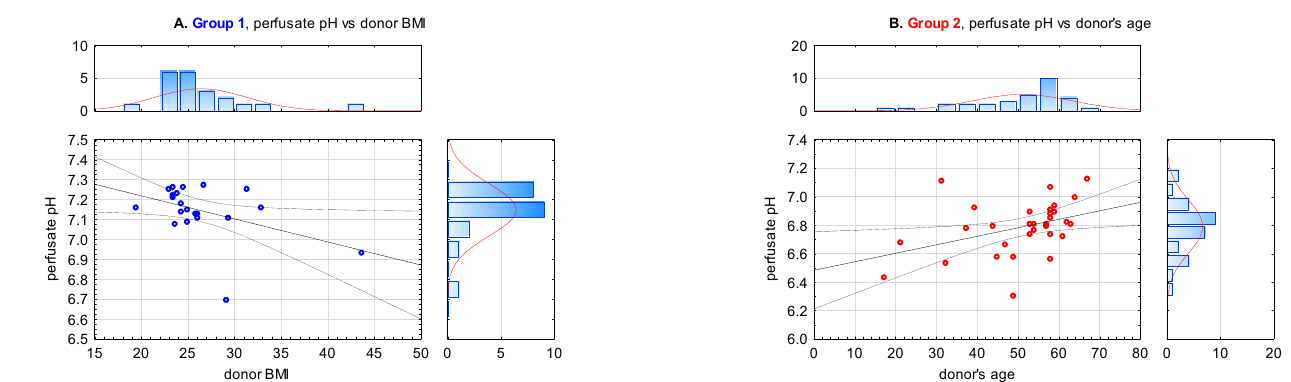
Figure 3. Scatterplots of correlations between perfusate pH and: ( A ). BMI in Group 1 (HMP) (R Spearman, p < 0.05 , n 1 = 26), ( B ). donor’s age in Group 2 (SCS) (Pearson test, p = 0.045 , n 2 = 40).